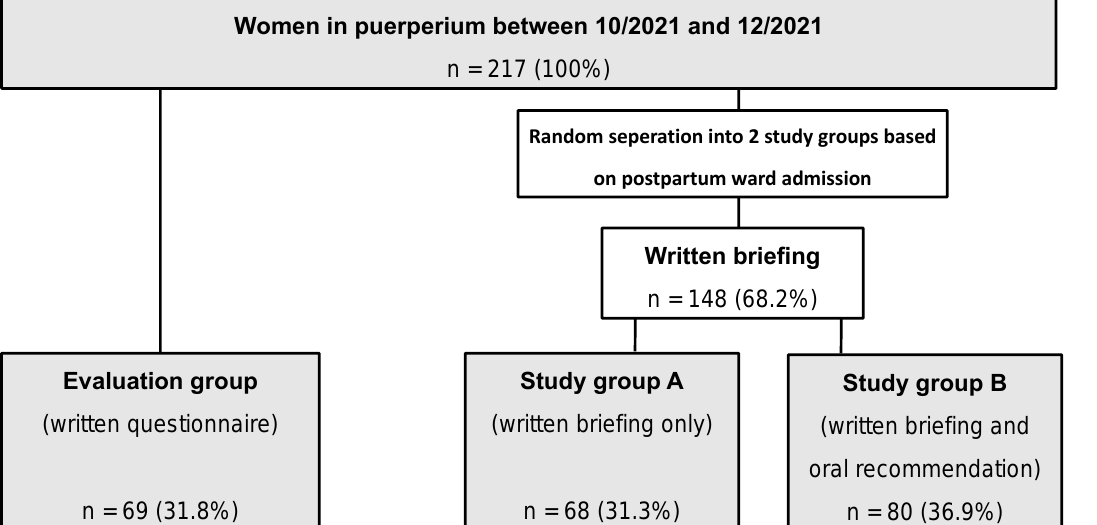
Figure 1. Patient flowchart. A total of 217 women in puerperium were included. A total of 69 (31.8%) patients were assigned to the evaluation group and received written questionnaires. A total of 148 patients were assigned to study groups A and B. Patients in study group A (n = 68, 31.3%) were handed out a written briefing recommending the SARS-CoV-2 vaccination during puerperium, while 80 (36.9%) patients were assigned to study group B and received an oral recommendation to undergo the SARS-CoV-2 vaccination during puerperium in addition to the written briefing. The median age (evaluation group: 31.5 years vs. A: 32.6 years vs. B: 32.5 years), migration background (evaluation group: 53.6% vs. A: 58.8% vs. B: 61.3%; p = 0.635) and delivery mode (vaginal—evaluation group: 52.2% vs. A: 50.7% vs. B: 51.2%; cesarean—evaluation group: 44.9% vs. A: 46.3% vs. B: 45.0%, instrumental—evaluation group: 2.9% vs. A: 3.0% vs. B: